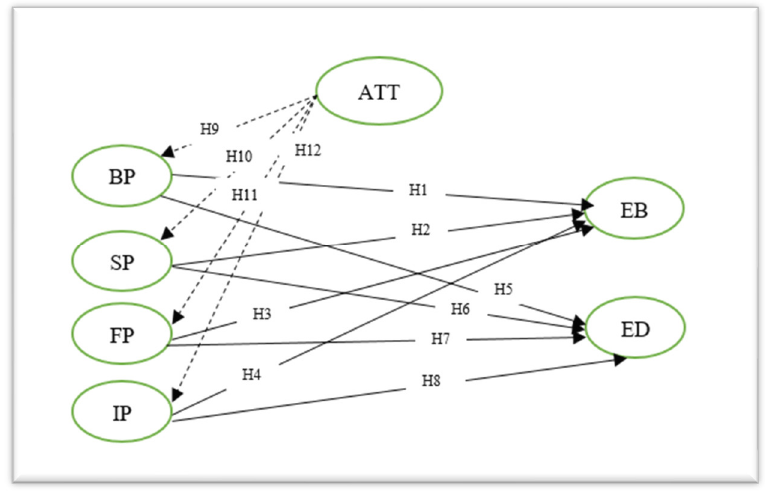
Figure 1. The research framework and hypotheses.